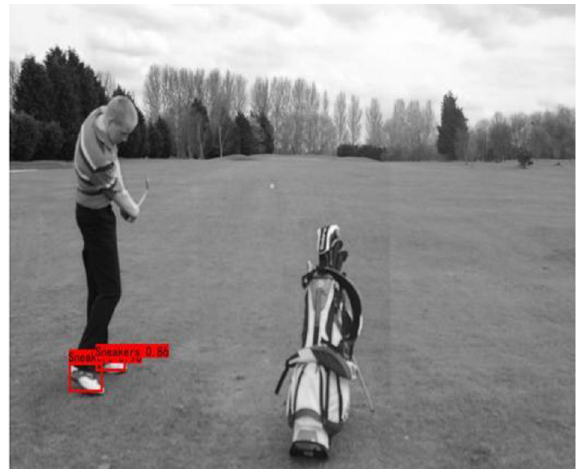
Fig. 11 SEHyptarget detection results (19th spectrum)